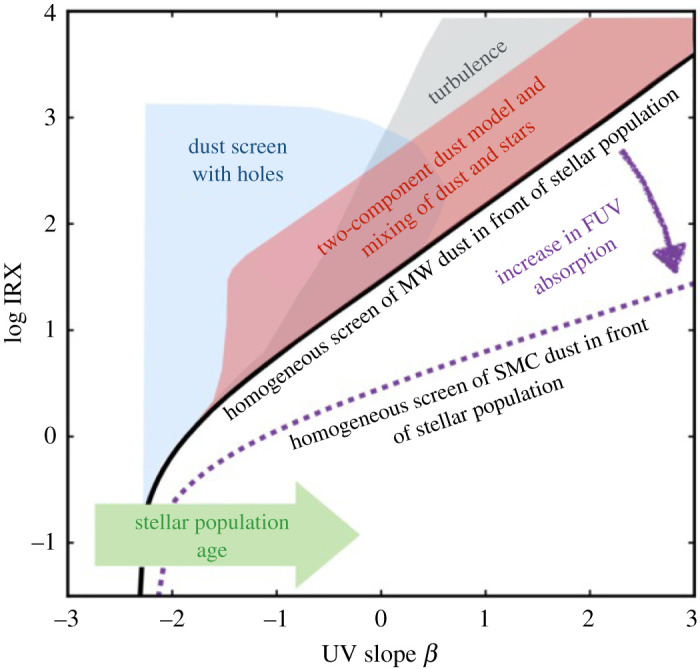
The various physical processes affecting the location of galaxies in the IRX-β plot according to the theoretical models of Popping et al. [399]. Figure from Popping et al. [399].